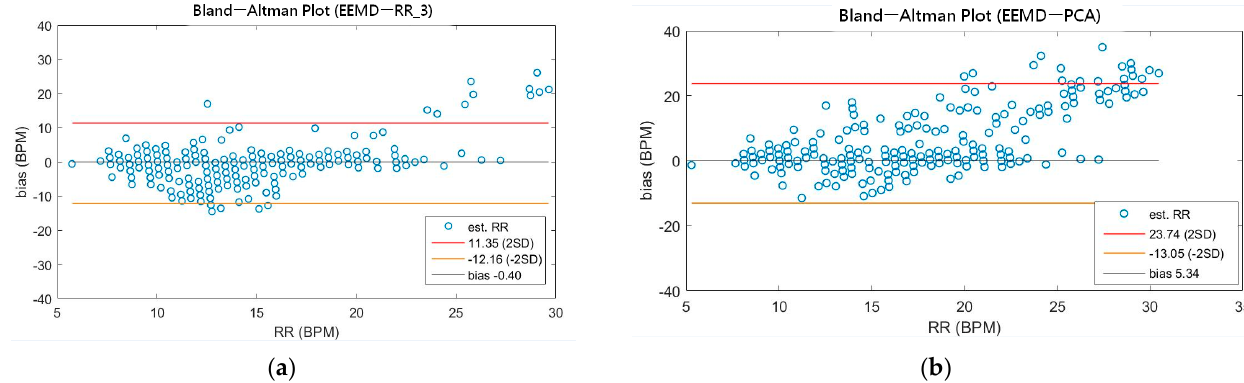
Figure 8. ( a ) The Bland-Altman plot of the estimated RR using EEMD-RR_3; ( b ) the Bland-Altman plot of the estimated RR